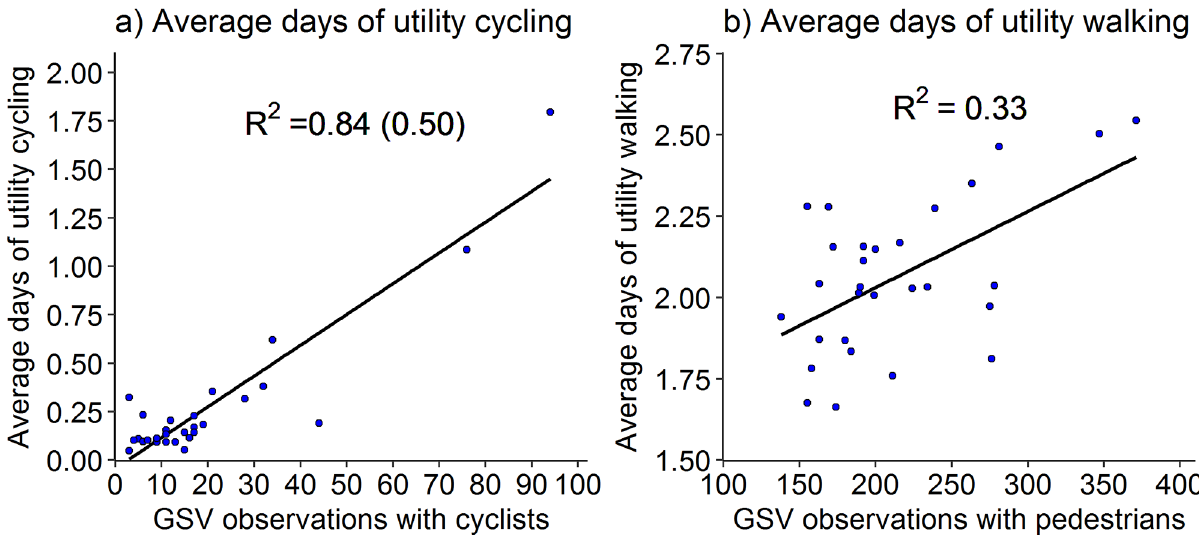
Fig 4. Linear relationships of GSV observations with APS measures of walking and cycling (4(a) includes R 2 using log transformed variables in parentheses to reduce the effect of outliers).